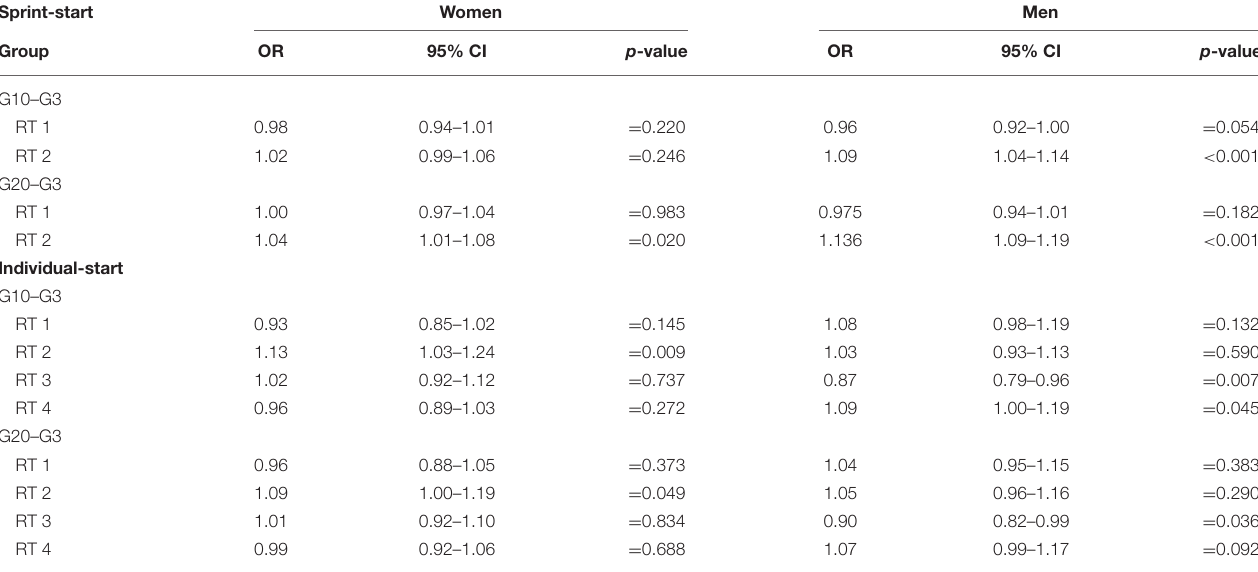
TABLE 2 | Multi-nominal logistic regression for range time in women’s and men’s sprint and individual competitions in IBU WC 2002/2003–2018/2019. Sprint-start